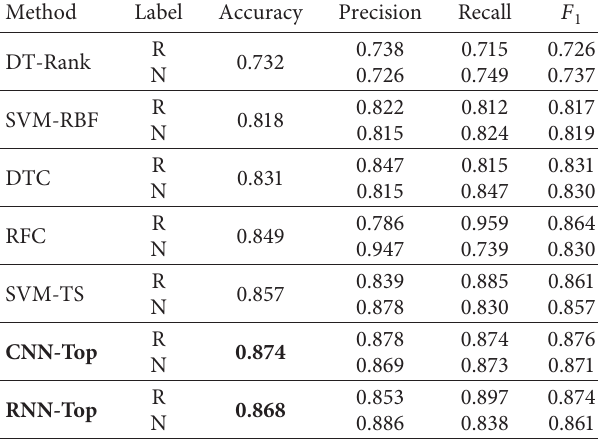
Table 3: Feature domain of the methods in contrast experiment. Method